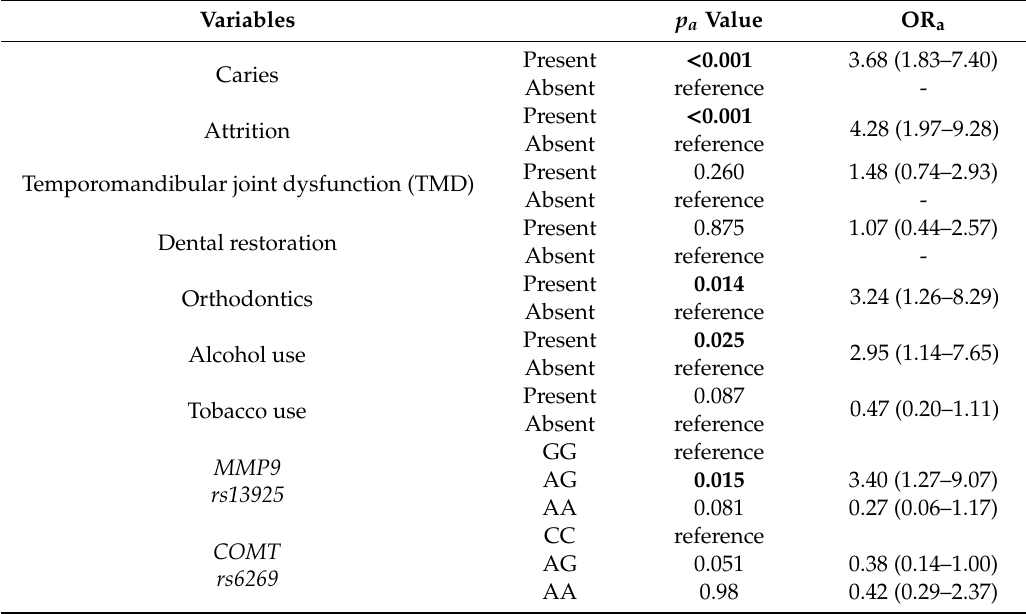
Multivariate regression analyses in adults, including only variables with p < 0.2, in univariate